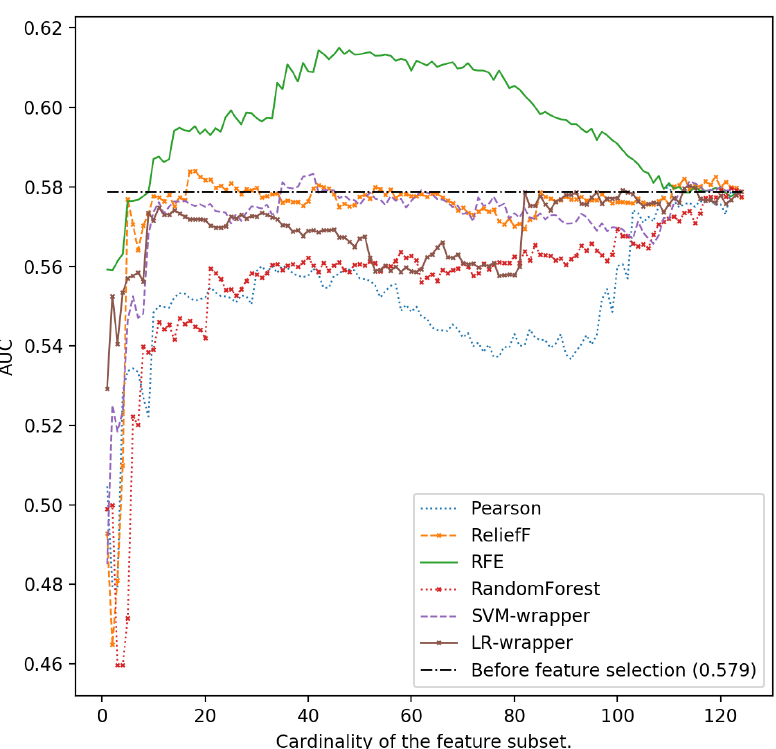
Figure 4. Area under the curve using the complete data set without reducing features and different cardinality of the subset of features for different classifiers: Multilayer Perceptron.